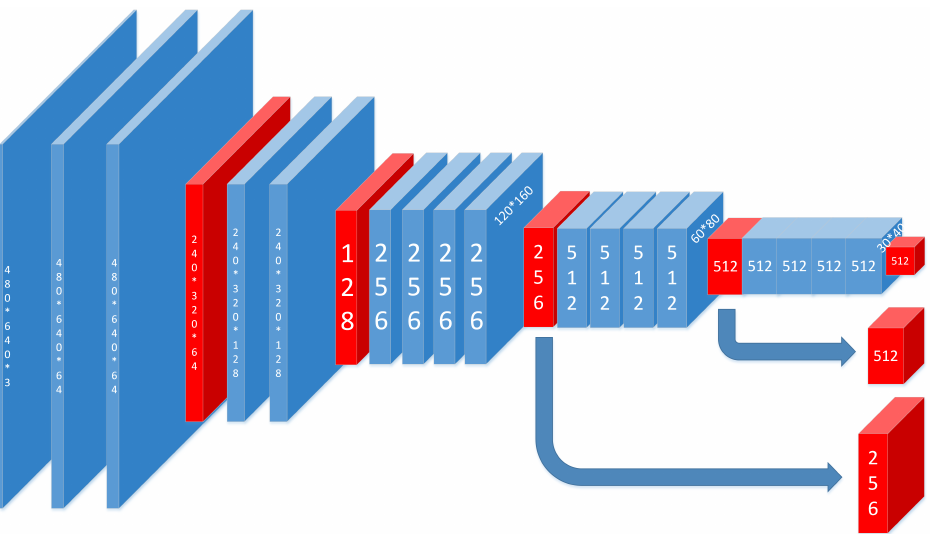
Figure 4. The figure maps of VGG19 in our approach. Blue ones are got from convolutional layer, and red ones are got from max-pooling layer. All the convolution kernels are in the size of 3 × 3. The size of the output is 15 × 20, 1/32 of the original image. At the same time, the figure maps got from pooling3 and pooling4 are also sent to next stage.